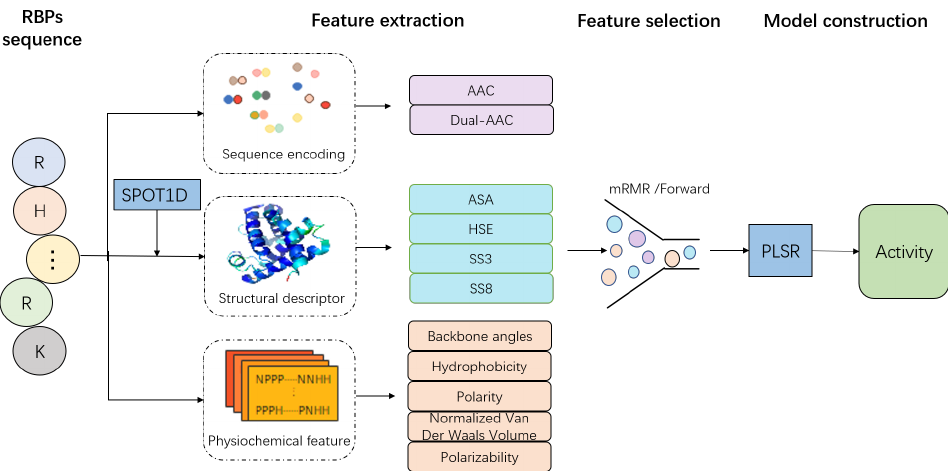
Figure 6. Methodology for predicting the activities of trans-acting splicing factors. RBPs is RNA binding proteins, AAC is amino acid composition, Dual-AAC is dual amino acid composition, ASA is solvent accessible surface area, HSE is half-sphere exposure, SS3 and SS8 is 3-state and 8-state secondary structural elements, respectively, and PLSR is partial least square